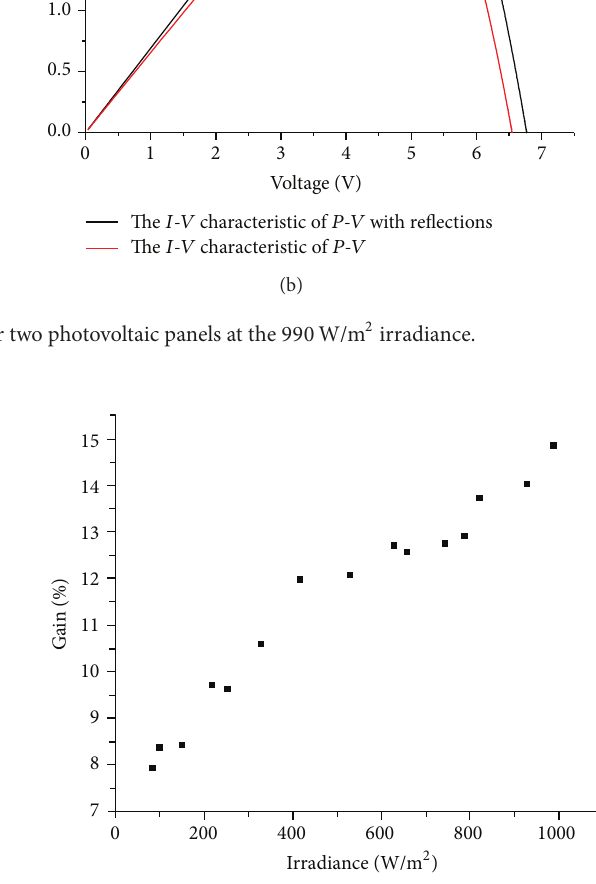
Figure5:ThepercentagegainofPVWcomparedtoPVBMfunction of the